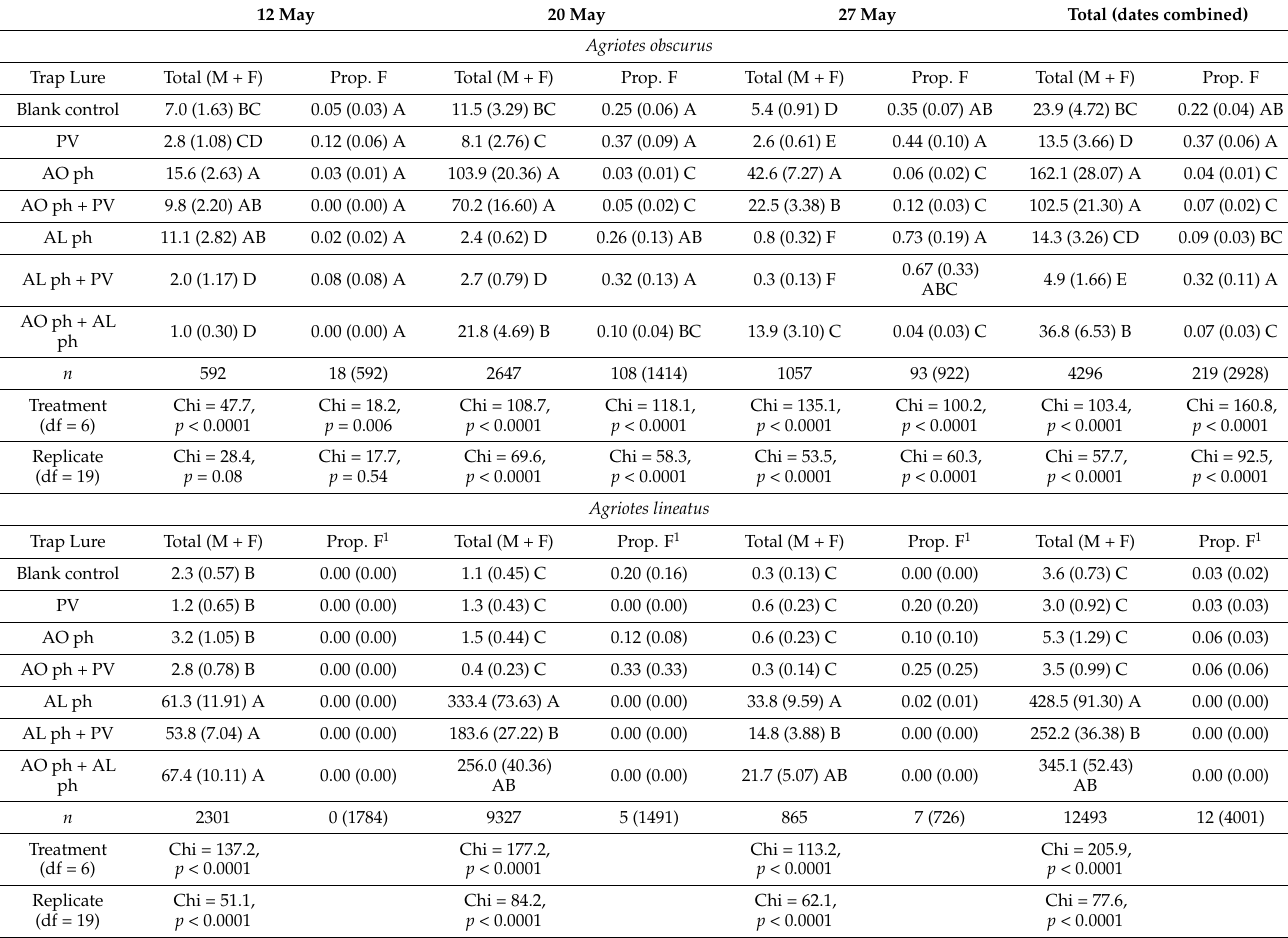
Table 2. Captures of male (M) and female (F) Agriotes obscurus (AO) and A. lineatus (AL) click beetles in traps baited with AO or AL sex pheromone (ph) and/or ( E )-anethol and ( E )-cinnamaldehyde, plant volatiles (PV) attractive to A. ustulatus , in 2021. Shown are mean (SEM) captures from 12 replicates. Prop. F = proportion female beetles from subsamples sexed per trap. n = number of beetles collected (M + F column), or number of females out of number that were sexed (Prop. F column). For each species, numbers in columns followed by the same letter are not significantly different ( α = 0.05; Tukey’s